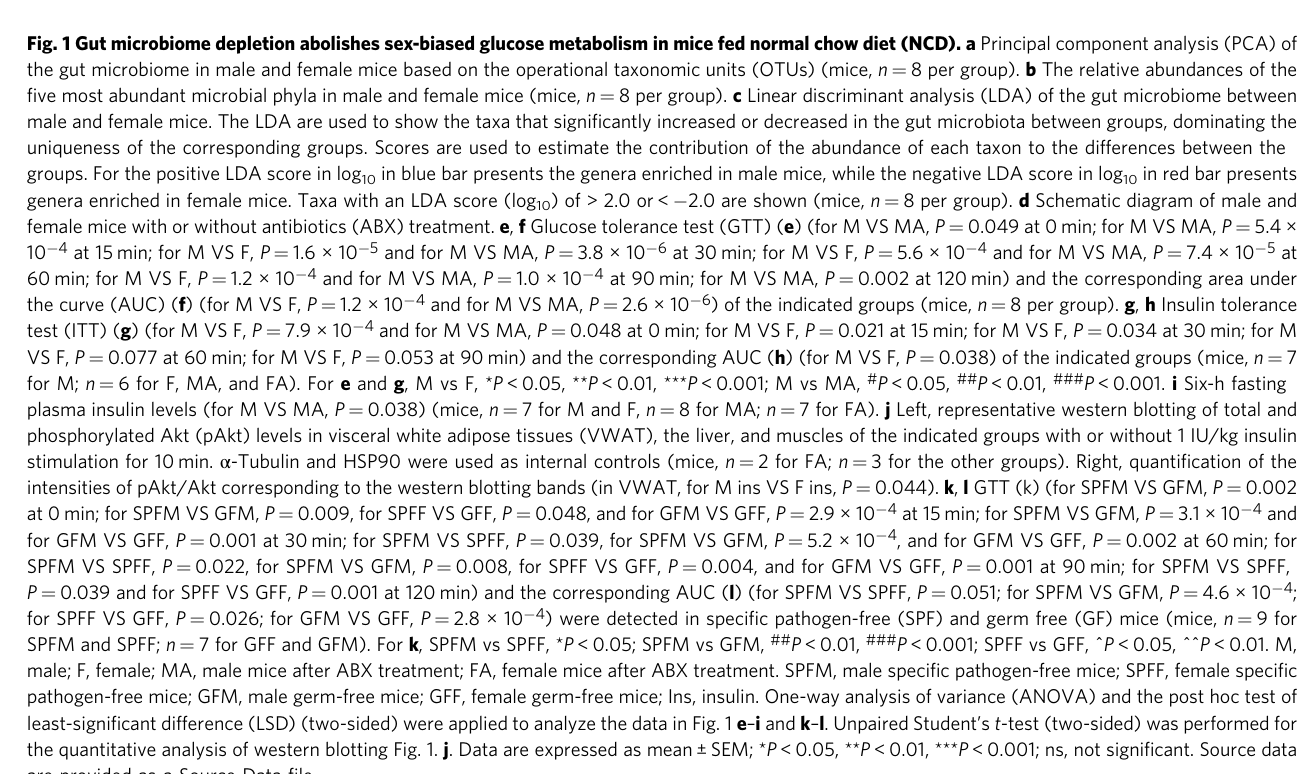
Fig. 1 Gut microbiome depletion abolishes sex-biased glucose metabolism in mice fed normal chow diet (NCD). a Principal component analysis (PCA) of the gut microbiome in male and female mice based on the operational taxonomic units (OTUs) (mice, n = 8 per group). b The relative abundances of the fi ve most abundant microbial phyla in male and female mice (mice, n = 8 per group). c Linear discriminant analysis (LDA) of the gut microbiome between male and female mice. The LDA are used to show the taxa that signi fi cantly increased or decreased in the gut microbiota between groups, dominating the uniqueness of the corresponding groups. Scores are used to estimate the contribution of the abundance of each taxon to the differences between the groups. For the positive LDA score in log 10 in blue bar presents the genera enriched in male mice, while the negative LDA score in log 10 in red bar presents genera enriched in female mice. Taxa with an LDA score (log 10 ) of > 2.0 or < − 2.0 are shown (mice, n = 8 per group). d Schematic diagram of male and female mice with or without antibiotics (ABX) treatment. e , f Glucose tolerance test (GTT) ( e ) (for M VS MA, P = 0.049 at 0 min; for M VS MA, P = 5.4 × 10 − 4 at 15 min; for M VS F, P = 1.6 × 10 − 5 and for M VS MA, P = 3.8 × 10 − 6 at 30 min; for M VS F, P = 5.6 × 10 − 4 and for M VS MA, P = 7.4 × 10 − 5 at 60 min; for M VS F, P = 1.2 × 10 − 4 and for M VS MA, P = 1.0 × 10 − 4 at 90 min; for M VS MA, P = 0.002 at 120 min) and the corresponding area under the curve (AUC) ( f ) (for M VS F, P = 1.2 × 10 − 4 and for M VS MA, P = 2.6 × 10 − 6 ) of the indicated groups (mice, n = 8 per group). g , h Insulin